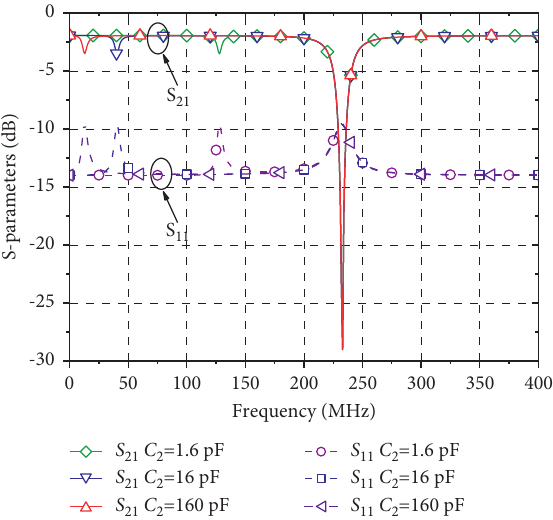
2 . 1 values when band-pass negative group delay